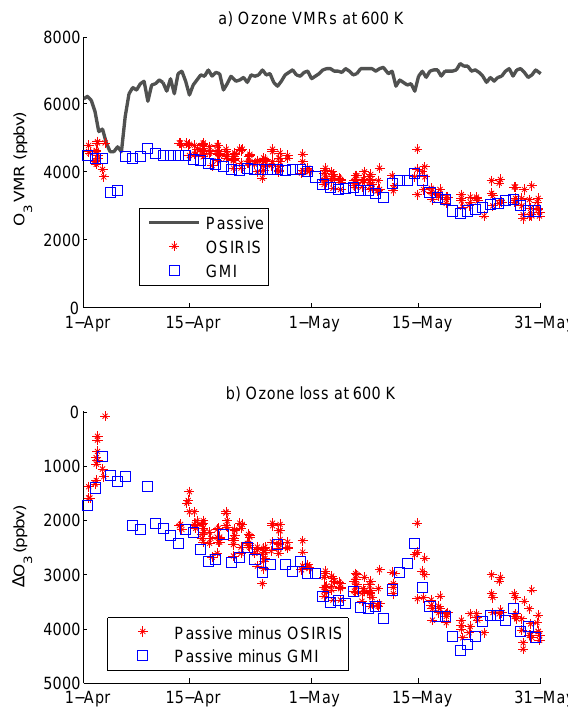
Fig. 8. (a) 2011 ozone VMRs (ppbv) at the 600-K potential temper- ature level from ATLAS passive ozone above Eureka (black line), OSIRIS ozone within 500 km of Eureka (red stars), and GMI ozone above Eureka (blue squares). (b) Ozone loss (ppbv) calculated for ATLAS passive ozone minus OSIRIS (red stars) and ATLAS pas- sive ozone minus GMI (blue